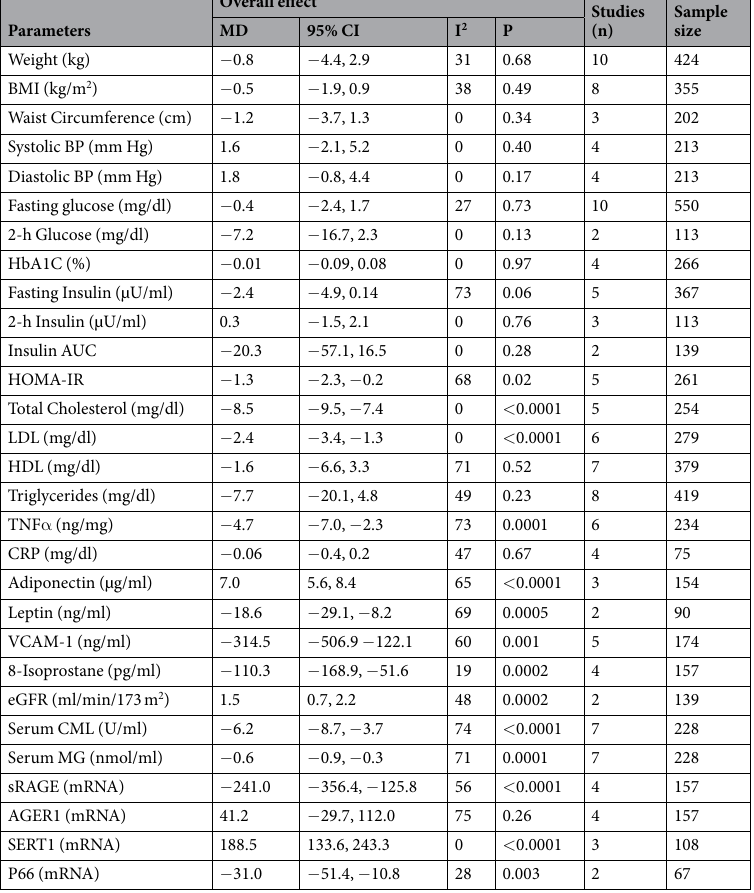
period (participants were masked to the allocation of the diet type and to how the diet might affect glucose metab- olism) 16, 27 whereas the remaining studies were not blinded 10, 15, 17–26, 28–30, 32–37 . In addition, seven studies described that investigators and care providers as well as outcome assessors were blinded 10, 16, 18, 25–27, 32, 34–37 . Intention-to-treat analyses were used in eight studies 10, 17, 18, 21–24, 29, 31, 34–37 . All of the crossover studies used a washout period of two or more weeks for interventions that lasted for 2 weeks or more 16, 18, 22, 30–33 except one study which used a 10 days washout period after a 4 week intervention 15 . Overall, five studies were rated with low risk of bias 16, 18, 26, 27, 31 , three with moderate risk of bias 10, 19, 23, 25, 34–37 and eight with insufficient information 15, 17, 20–24, 28–30, 32, 33 . Effects of dietary AGEs on cardiometabolic parameters Anthropometric and blood pressure measurements. There was no significant difference between low and high AGE diets with regards to weight (MD − 0.8 kg, 95% CI − 4.4 to 2.9) 16, 18, 19, 21–23, 26–29 , body mass index blood pressure 22, 23, 26, 29 (Table 1). Subgroup analyses also did not reveal any differences in these measurements between the two diets with regards to participant’s T2DM status, amount of dietary AGEs and length of follow-up (Supplemental Table 3). Measures of glucose homeostasis. Glycaemic control . There was no significant difference between low and high AGE diets with regards to fasting glucose (MD − 0.4 mg/dl, 95% CI − 2.4 to 1.7) 15, 17–19, 22–24, 26, 27, 29 , 2-h (Table 1). It was not possible to conduct meta-analysis for glucose area under the curve (AUC) as there was only one study that reported on this measure 23 .